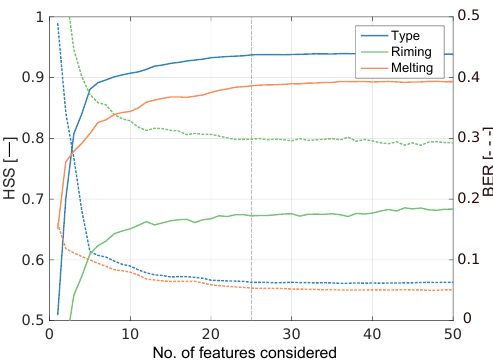
Figure 5. Evolution of the HSS (full lines) and BER (dashed lines) as we increase the number of features used in the model. The three color codes represent hydrometeor-type classification (blue), riming degree (green) and melting snow detection (orange), respectively. Features added on the right of the vertical dashed line are discarded.